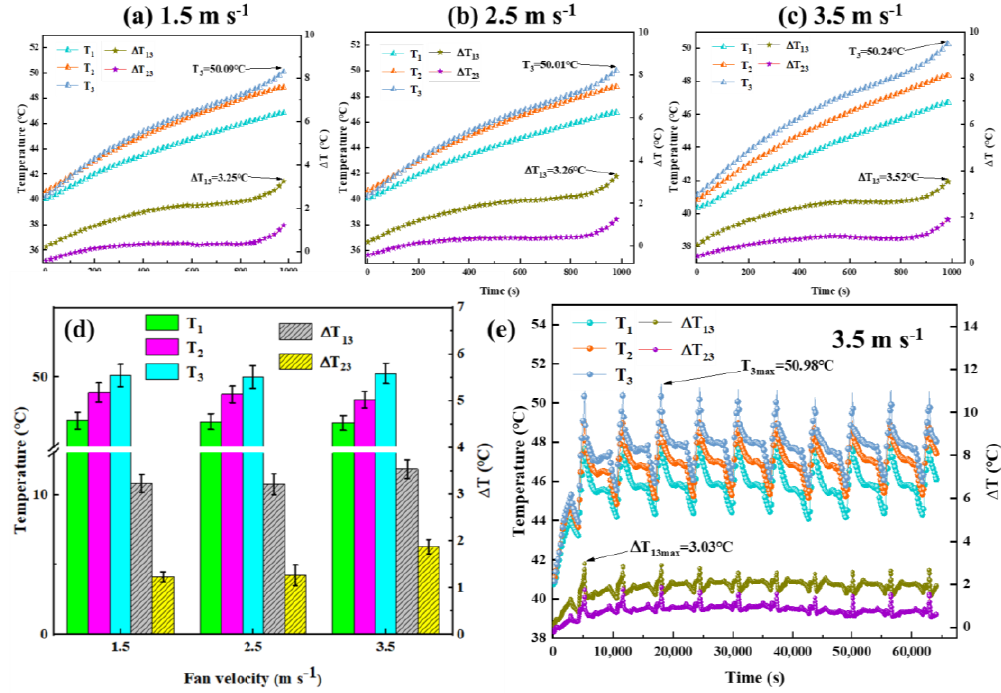
Figure 6. The temperature variation curves and ∆ T variation curves of the CPCM-air module with different air velocities of ( a ) 1.5, ( b ) 2.5 and ( c ) 3.5 m s −1 ; ( d ) Comparison of the testing results at the end of the discharge process; ( e ) temperature control performance of the CPCM-air module during 10 charge-discharge cycles.